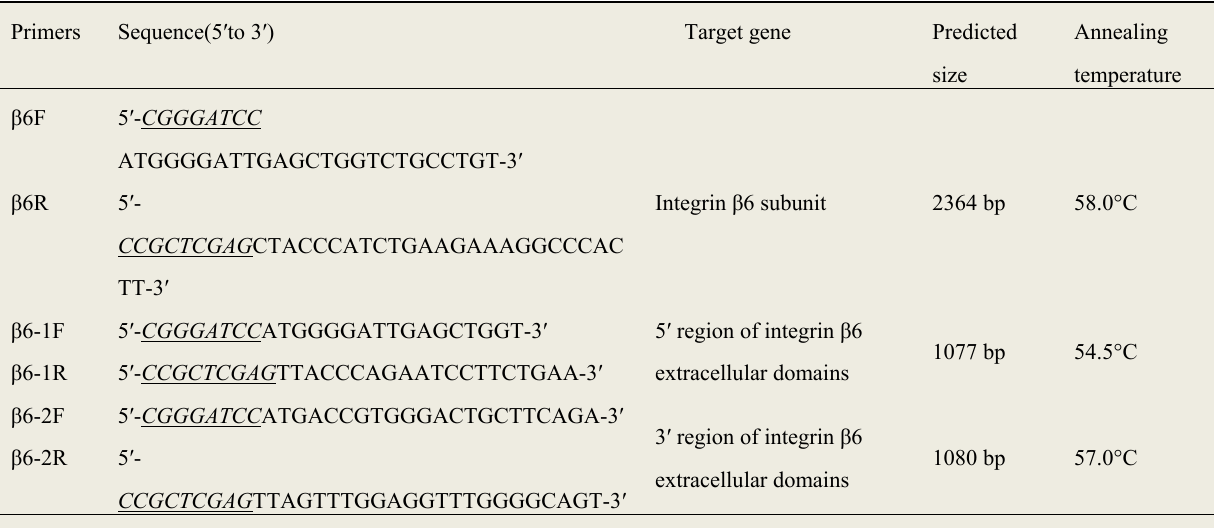
Table 2. Primers used in the cloning of the integrin β 6